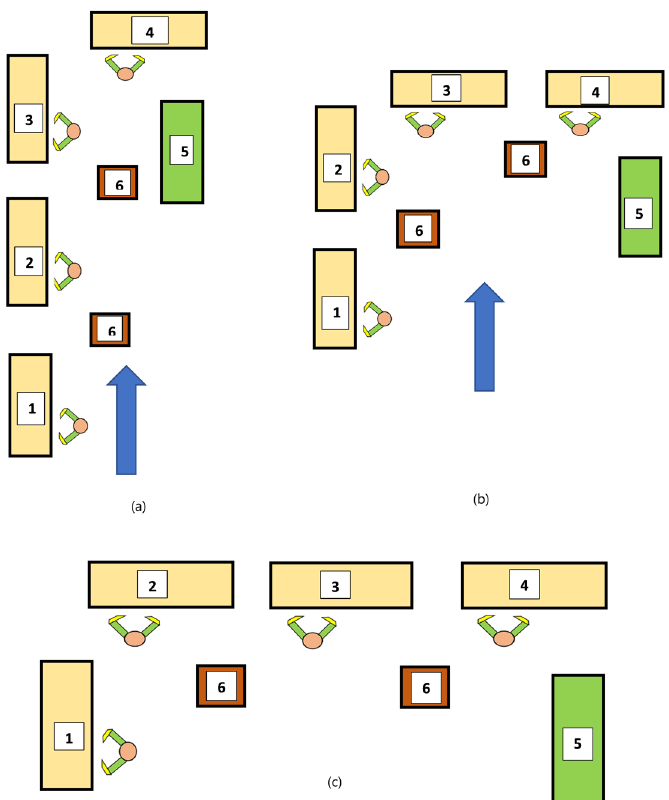
Figure 7. Right angle configuration ( a – c ). Variant 2, in series, of a training cell ( a ); Right angle configuration, V8 variant ( b ); Right angle configuration, V9 variant ( c ). The modules are: 1, 2, 3, 4—Work modules; 5—Control module; 6—Mobile transport modules to the control module.